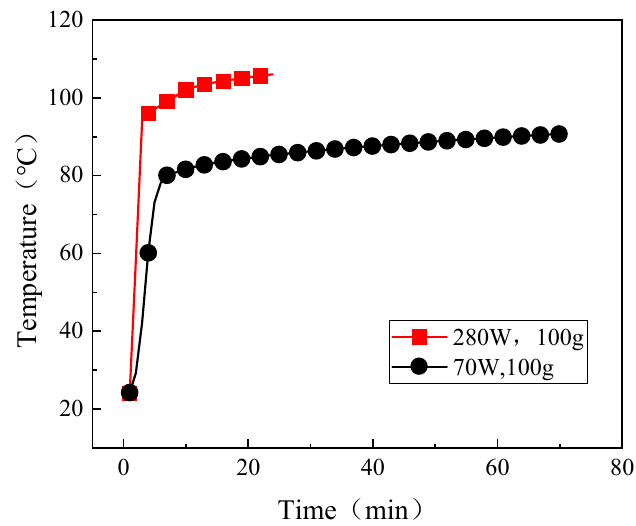
Figure 4. Drying temperature of corn under different microwave powers.